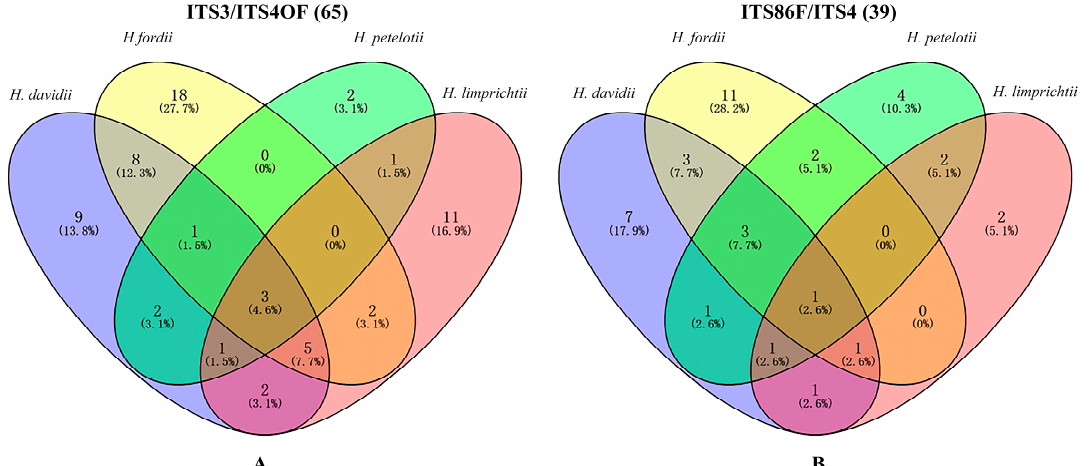
Figure 2. Venn diagrams showing the distribution of OTUs corresponding to OMF previously described in the studied orchid species (refer to Table S2) using primer pairs ( A ) ITS3/ITS4OF and ( B ) ITS86F/ITS4 between the studied orchid species ( Habenaria davidii , H. fordii , H. petelotii , and H. limprichtii